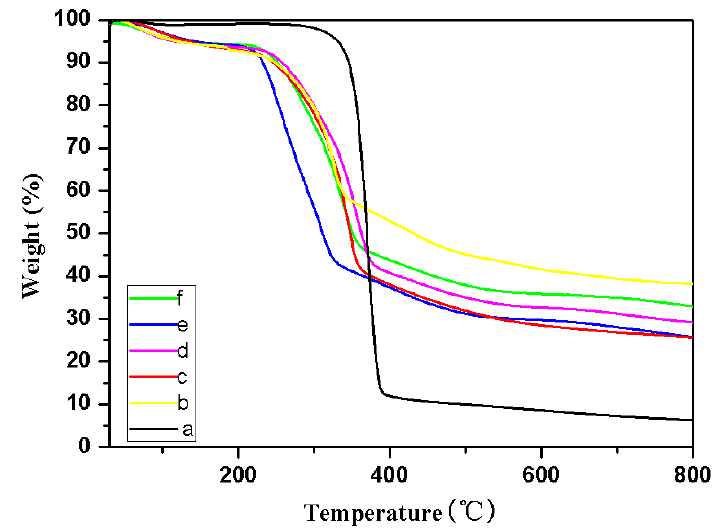
Figure 5. TG curves of cellulose (a), cellulose-COOZn (b), cellulose-COOMg (c), cellulose-COOCa (d), cellulose-COONa (e), and cellulose-COOBa (f) under N 2.